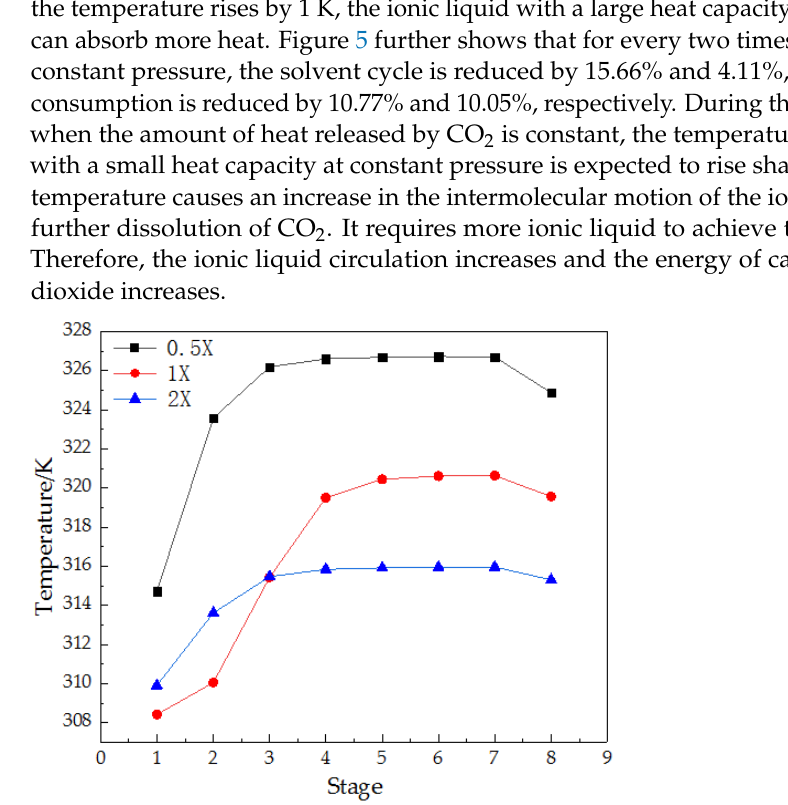
Figure 5. The influence of heat capacity at a constant pressure of [emim][Tf 2 N] on the volume of solvent circulation and energy consumption. The red areas represent solvent consumption and the shaded areas represent electrical power consumption. 3.4. Influence of Physical Properties of Ionic Liquid on Heat Exchanger Design The heat exchanger is essential equipment in industrial production. The physical properties of the ionic liquid have a certain impact on the design and choice of the heat exchanger. Therefore, this section proposes the same hypothesis: under the premise of the